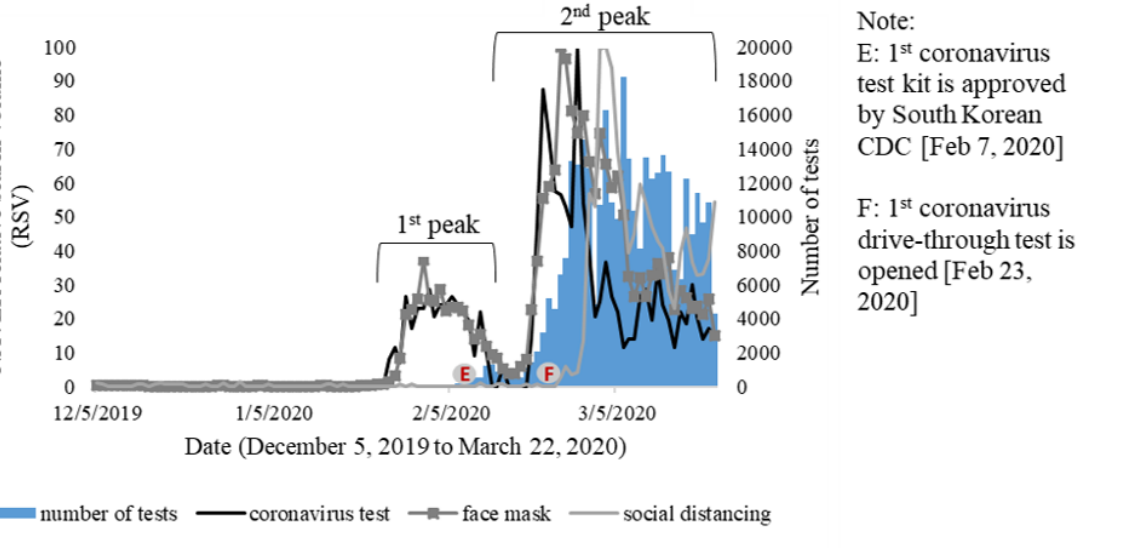
Figure 3. Time series of the daily number of coronavirus tests and NAVER relative search volumes related to coronavirus tests, face masks, and social distancing in South Korea. CDC: Centers for Disease Control and